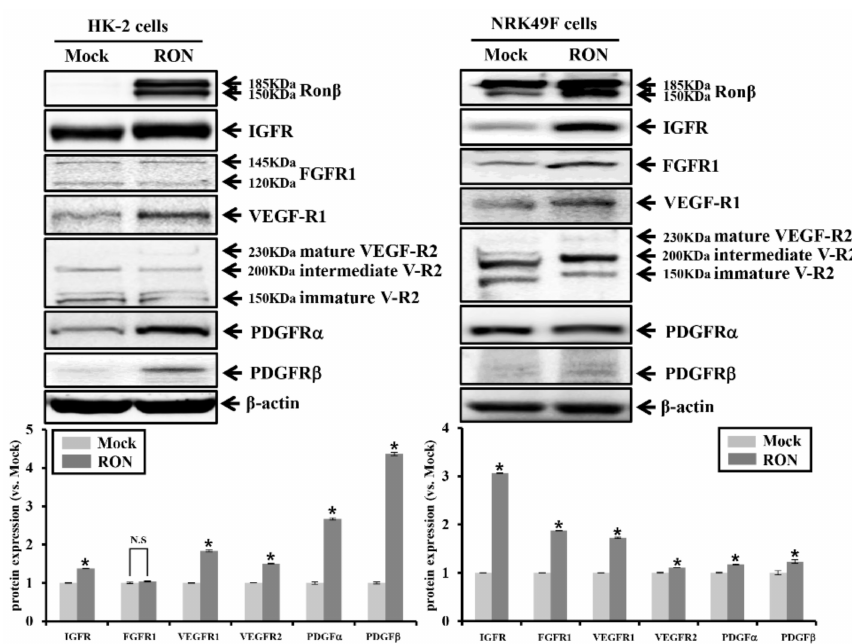
Figure 3. Protein expression of receptor tyrosine kinases (RTKs) by RON overexpression in HK-2 and NRK49F cells. Protein expression of IGFR, FGFR1, VEGFR1, VEGFR2, PDGFR α , and PDGFR β by RON overexpression was analyzed. Each column represents the mean ± SEM. * p < 0.05, compared with the Mock. N.S, statistically not significant. IGFR, insulin-like growth factor receptor; VEGFR, vascular endothelial growth factor receptor; PDGFR, platelet-derived growth factor receptor.